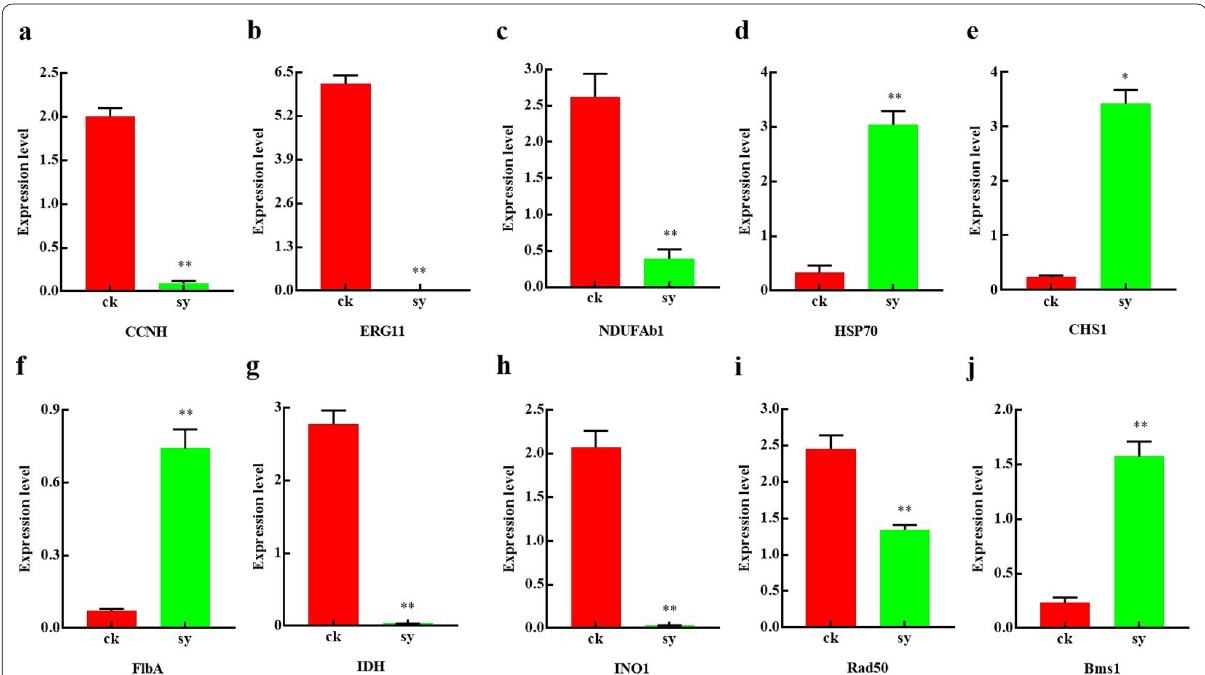
Fig. 4 Relative expression levels profiling of candidate DEGs in responding to X33 AMOP treatment by qRT-PCR. The actin gene is used as the housekeeping gene. a . Relative expression levels of basal transcription factors CCNH; b Relative expression levels of 14-alpha sterol demethylase encoding ERG11 gene; c Relative expression levels of acyl carrier protein NDUFAb1; d Relative expression levels of heat shock protein 70; e Relative expression levels of chitin synthase A; f Relative expression levels of regulator FlbA; g Relative expression levels of isocitrate dehydrogenase; h of ribosome biogenesis protein